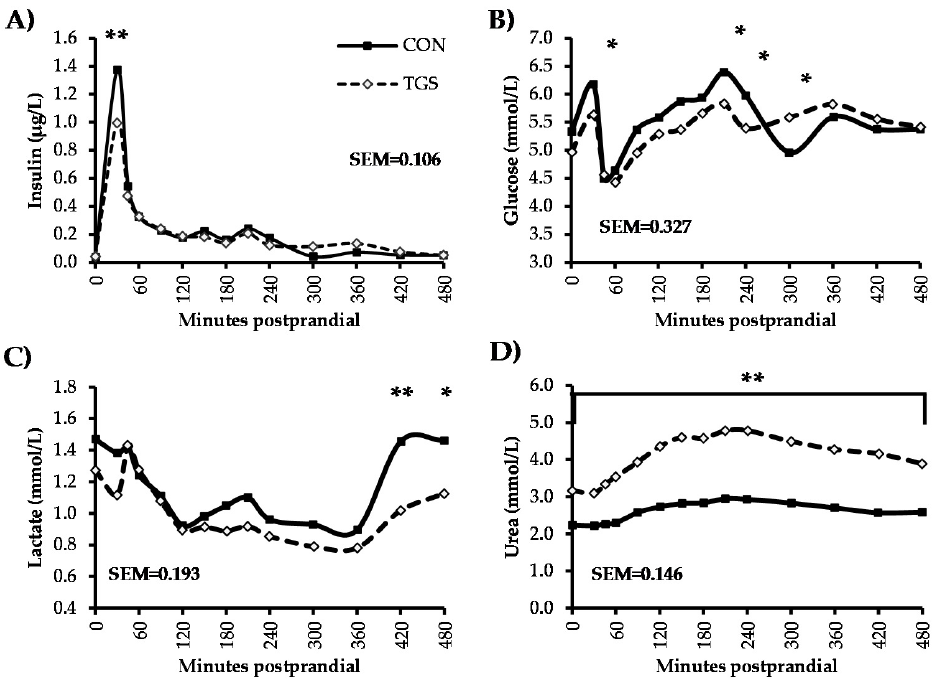
Figure 1. Insulin ( A ); glucose ( B ); lactate ( C ); and urea ( D ) in blood serum or plasma from pigs fed control (CON) or transglycosylated starch (TGS) diet. Data are presented as least square means;